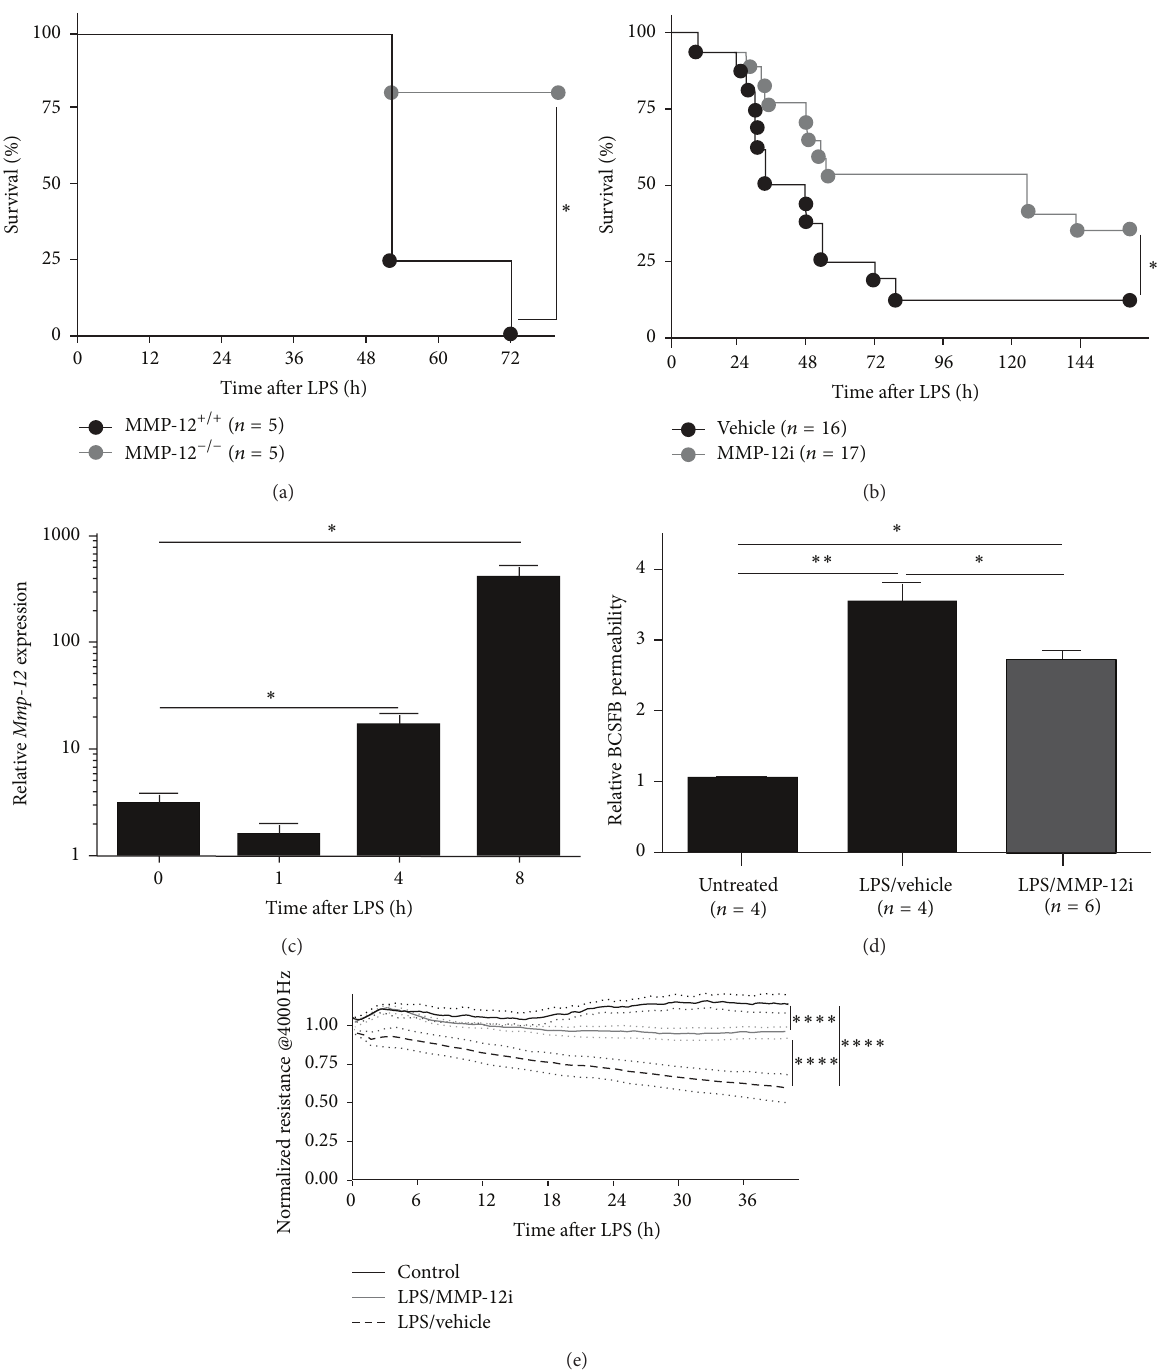
Figure 2: In vivo and in vitro effect of MMP-12 inhibition in endotoxemia. (a) Survival in function of time of MMP-12 +/+ (black) and MMP- 12 −/− (grey) mice following i.p. challenge with a lethal dose of LPS. (b) Survival in function of time of C57BL/6 mice injected with vehicle (black) or MMP-12i (grey) following i.p. challenge with a lethal dose of LPS. (c) Relative Mmp-12 expression in choroid plexus tissue isolated before and 1, 4, and 8 hours after LPS challenge ( 𝑛 = 3 -4). (d) Relative permeability of the blood-CSF barrier determined by measuring leakage of fluorescently labeled dextran (4 kDa) from the blood into the CSF 8 hours after LPS challenge in vehicle (black) and MMP-12i (grey) treated wild type mice, compared to PBS injected wild type mice. (e) Normalized resistance measured at low frequency using the ECIS instrument of primary choroid plexus epithelial cells incubated with vehicle (black), 1000ng/mL LPS (black dotted line), and 1000ng/mL LPS pretreated with 1 𝜇 M MMP-12 inhibitor (grey) ( 𝑛 = 3 ). Data are presented as means ± standard error of mean (sem). Survival curves were compared using a log-rank test. Other data were analyzed by Student’s t -test. ∗ 0.01 ≤ 𝑃 < 0.05 ; ∗∗ 0.0001 ≤ 𝑃 < 0.001 ; ∗∗∗∗ 𝑃 < 0.0001